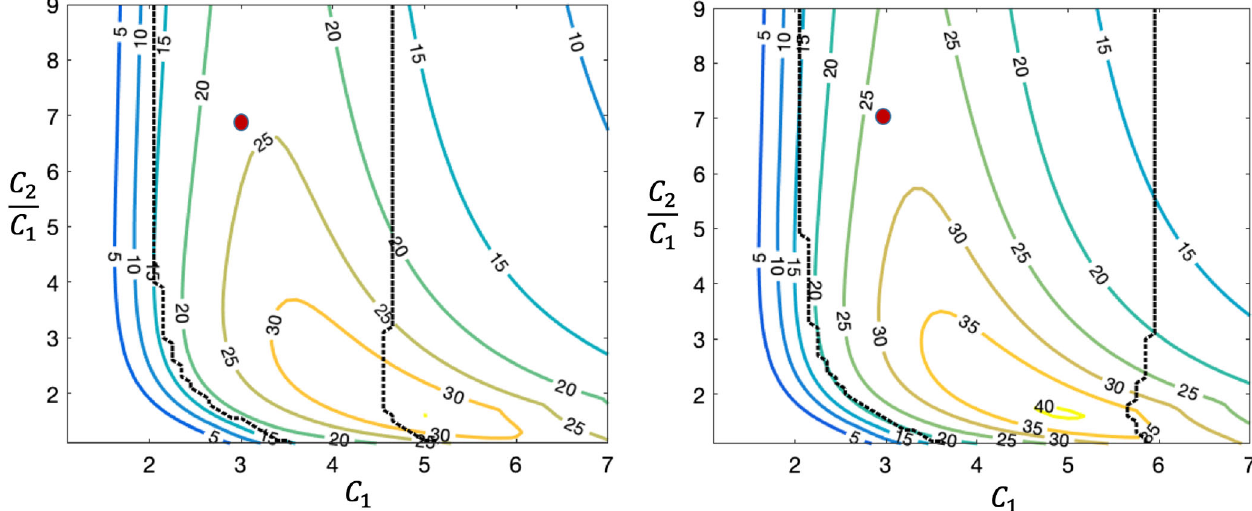
FIG. 7. The left plot shows the rf tolerance of the booster θ 1 ; 1 10 5 for the bunch charge of 500 pC compressed to the peak current of 10 kA. The right plot shows the same tolerance for the bunch charge of 250 pC compressed to the peak current of 5 kA. The red points show the working points. The dashed lines show the limits of the available rf